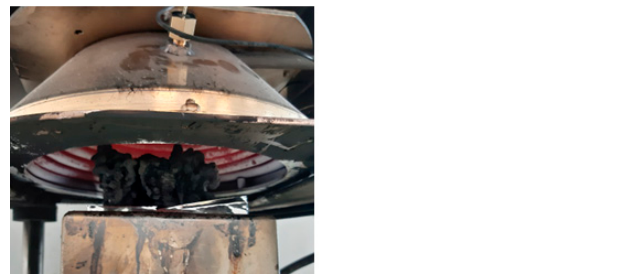
Figure 5. Burning behavior of TPS/10M during cone calorimetry tests.